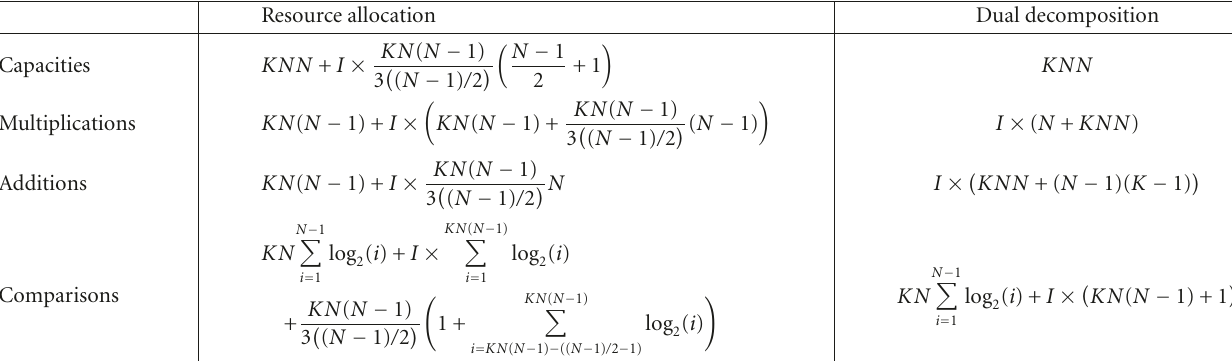
Algorithm 5: Multiuser dual decomposition algorithm. Table 2: Complexity comparison multiuser